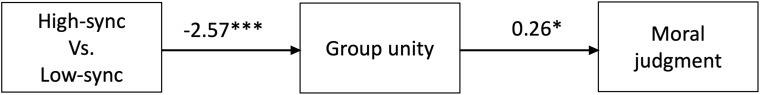
The mediation model. Note that the estimated slopes are different from those displayed in Table 2 because we did not included sex as covariate in the mediation analysis. Note: ∗p < 0.05, ∗∗∗p < 0.001.